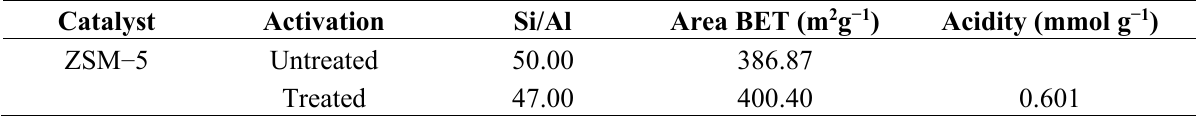
Table 1. Characteristics of zeolites in the